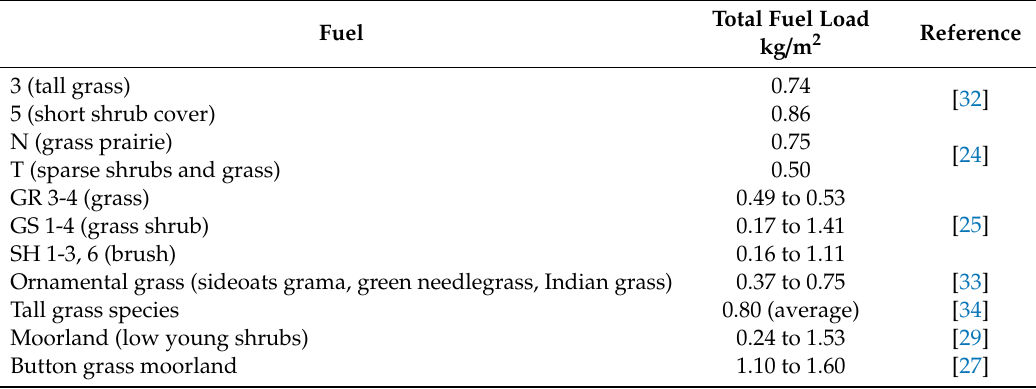
Table 1. Fuels chosen for extensive green roofs. Table 2. Fuels chosen for semi-intensive green